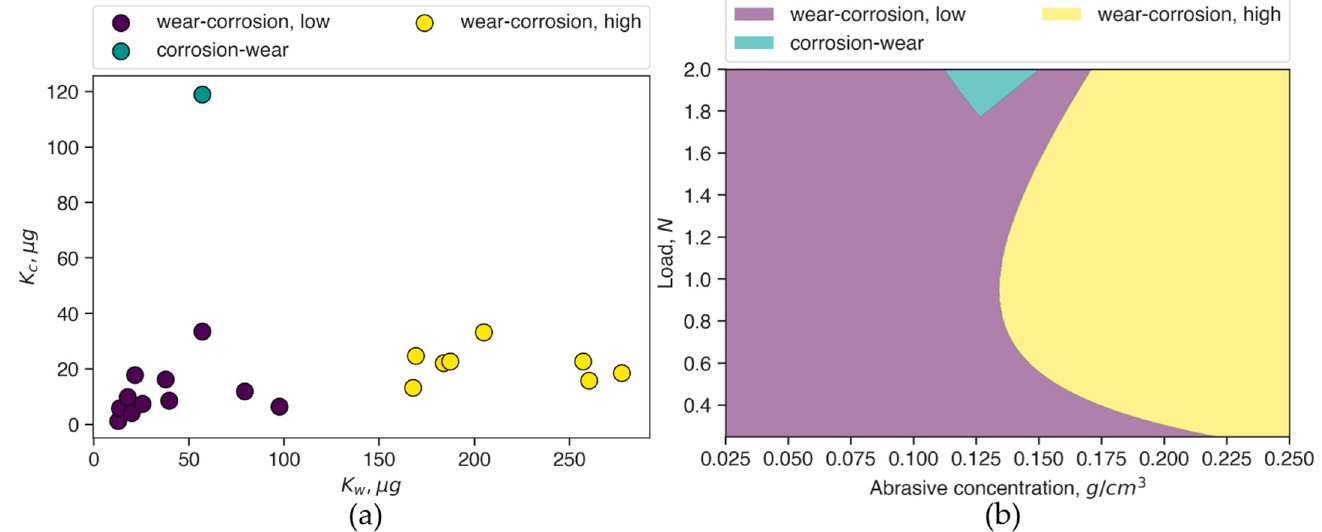
Figure 3. ( a ) Three clusters in dataset 1 identified using K -means clustering; and ( b ) the tribocorrosion mechanism map using support vector machines (SVMs) for the titanium alloy.